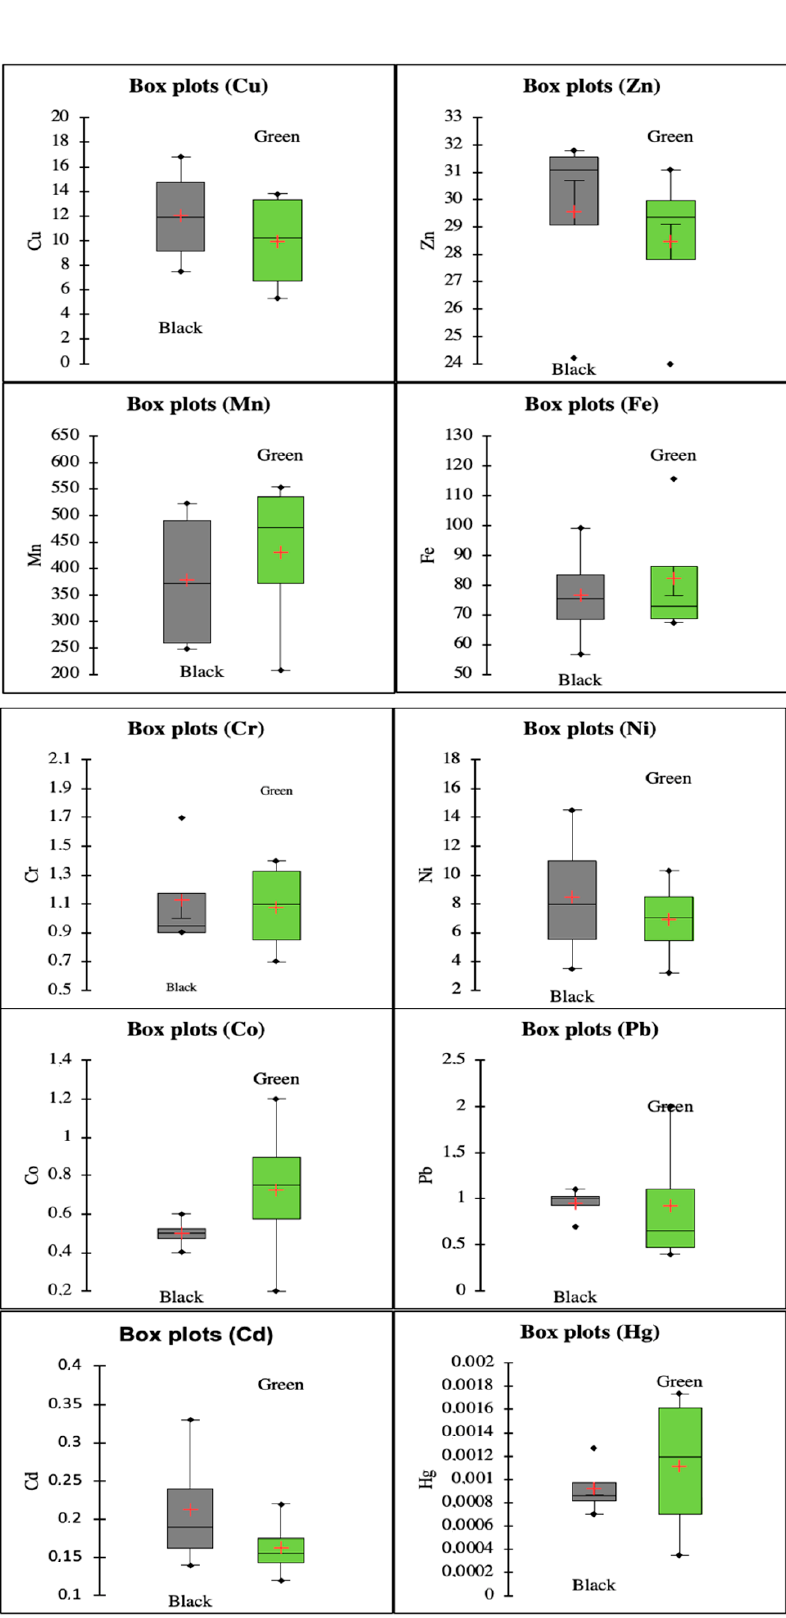
Figure 2. Boxplots of heavy metal concentration in relation to the fermentation process used.